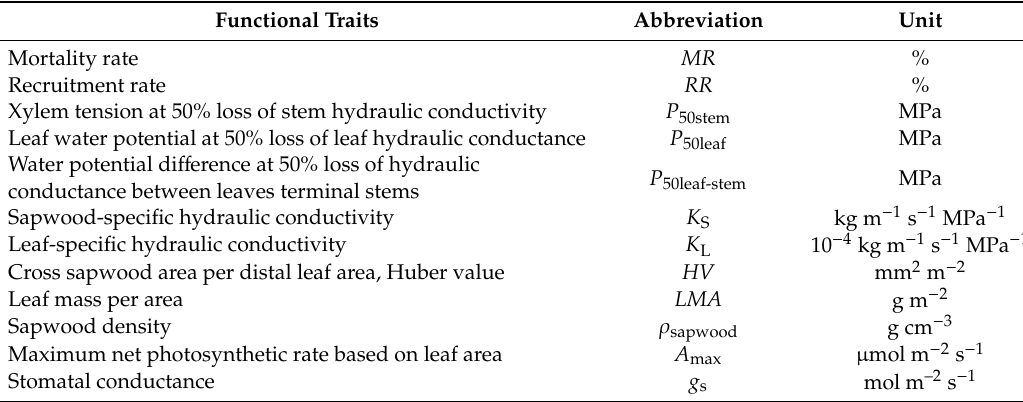
Table 1. The functional traits, their abbreviations, and units in this study. Functional